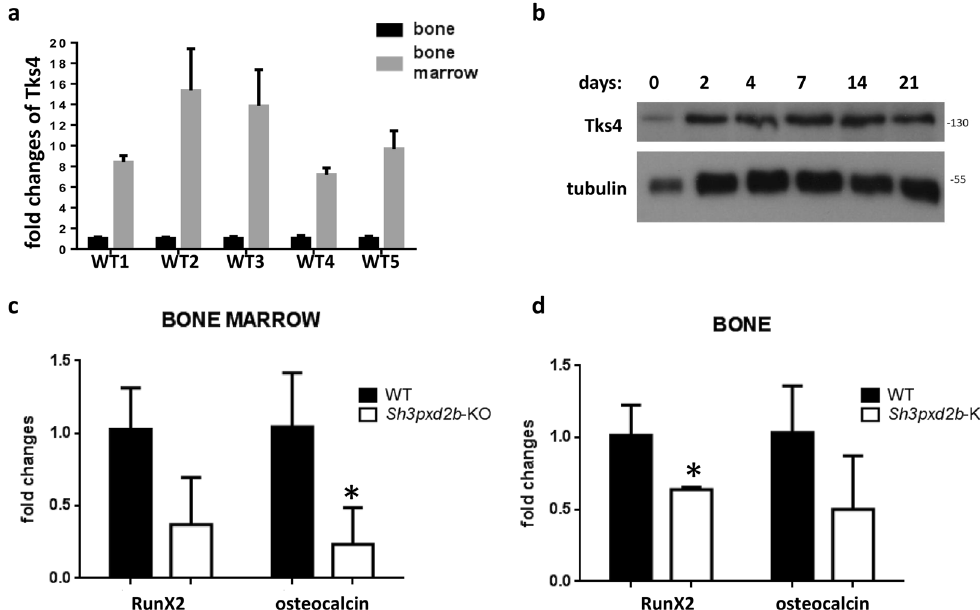
Figure 5. Examination of osteoblast markers. ( a ) The Tks4 expression levels were quantified separately in femoral hard bone tissue and BM by RT-PCR. The fold-change differences in the Tks4 mRNA levels were measured in five wild type mice (WT1-WT5), and the fold-changes were calculated using the 2 −ΔΔ Ct method. ( b ) BM-MSCs isolated from wild type mice were cultured and differentiated into the osteogenic lineage. Cell lysates were collected during the differentiation period on days 0, 2, 4, 7, 14, and 21, and the Tks4 protein levels were measured using western blotting. Tubulin was used as the loading control. The expression levels of the RunX2 and osteocalcin bone formation markers were measured by RT-PCR separately in BM ( c ) and hard bone tissue ( d ). Three 7-month-old mice were used per genotype. The data are presented as the mean ± SEM, and the differences were analyzed by Student’s t-test. * p <